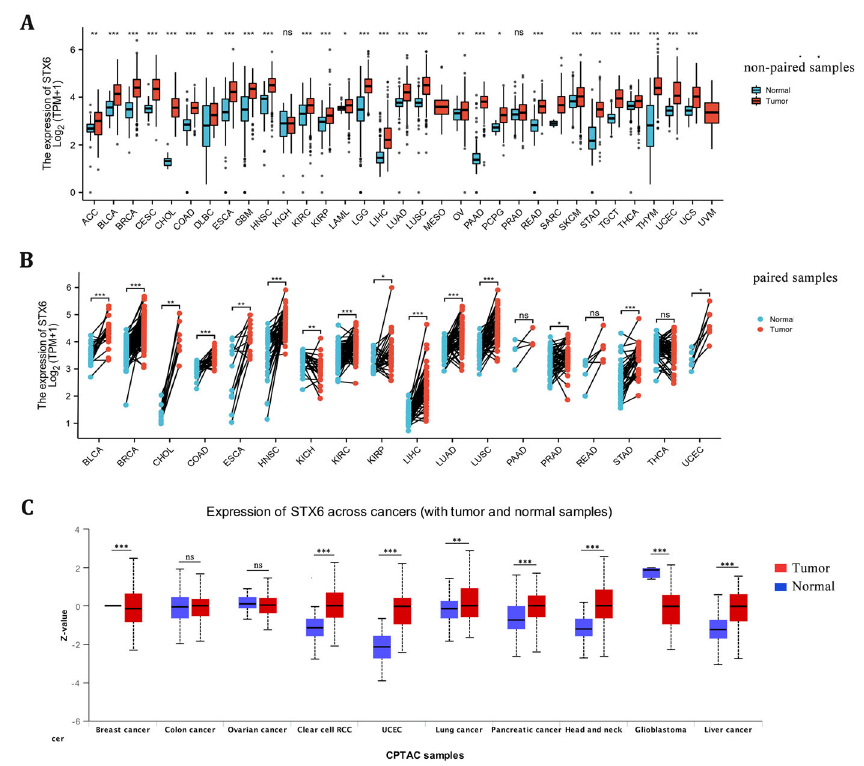
Figure 1. The mRNA and protein levels of STX6 are significantly upregulated in pan-cancer tissues compared to normal tissues. The mRNA level of STX6 is overexpressed in pan-cancer tissues compared to normal samples based on the data from TCGA and GETx databases ( A , B ). The same trend was observed at the protein level, especially in clear cell RCC, UCEC, head and neck cancer, and liver cancer ( C ). * p < 0.05, ** p < 0.01, and *** p < 0.001. ns: not significant.